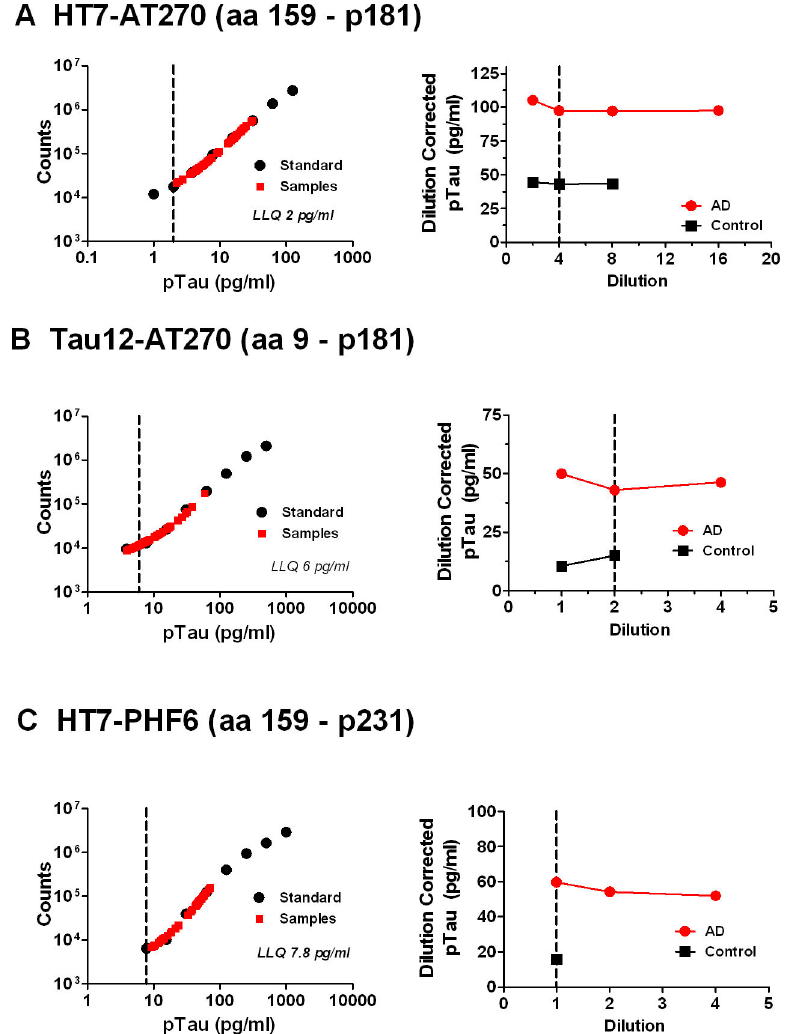
Figure 5. Characterization of ptau assays. Representative ptau standard curves (left panels) and CSF dilution linearity results (right panels) shown for A) HT7-AT270, B) HT7-PHF6, and C) Tau12-AT270 ptau ELISAs. On each standard curve graph, ptau calibrators (Standards) and results for CSF sample dilutions (Samples) are shown. The assay lower limit of quantitation (LLQ, vertical dashed line) is also indicated. On each dilution linearity graph, dilution-corrected ptau levels for a pooled control and a pooled AD CSF samples relative to sample dilution are shown. The vertical dashed lines indicate the dilution determined to be optimal for CSF